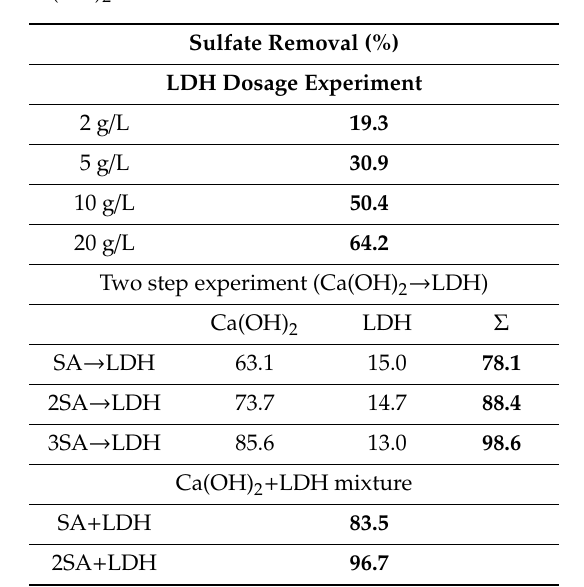
Table 2. The summary of results obtained for the LDH dosage experiment, two step experiment (Ca(OH) 2 → LDH), and Ca(OH) 2 + LDH mixture.